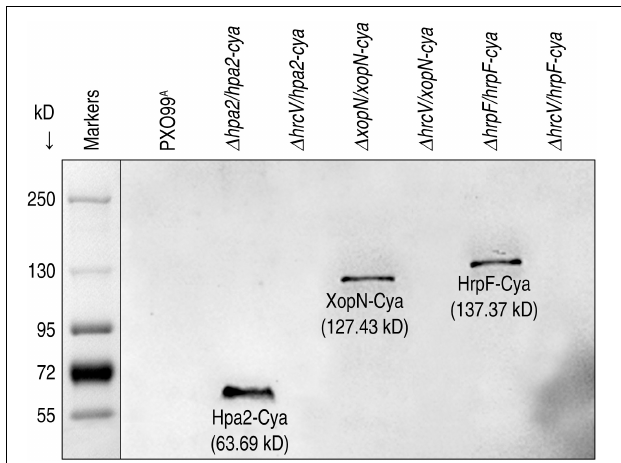
FIGURE 6 | Hpa2, HrpF, and XopN translocation. Each of the three proteins was fused to a Cya sequence and introduced in the fusion form into bacteria of the PXO99 A mutants. Bacterial cultures of PXO99 A and the mutants were used to isolate soluble proteins. Protein samples were analyzed by immunoblotting with the specific antibody against